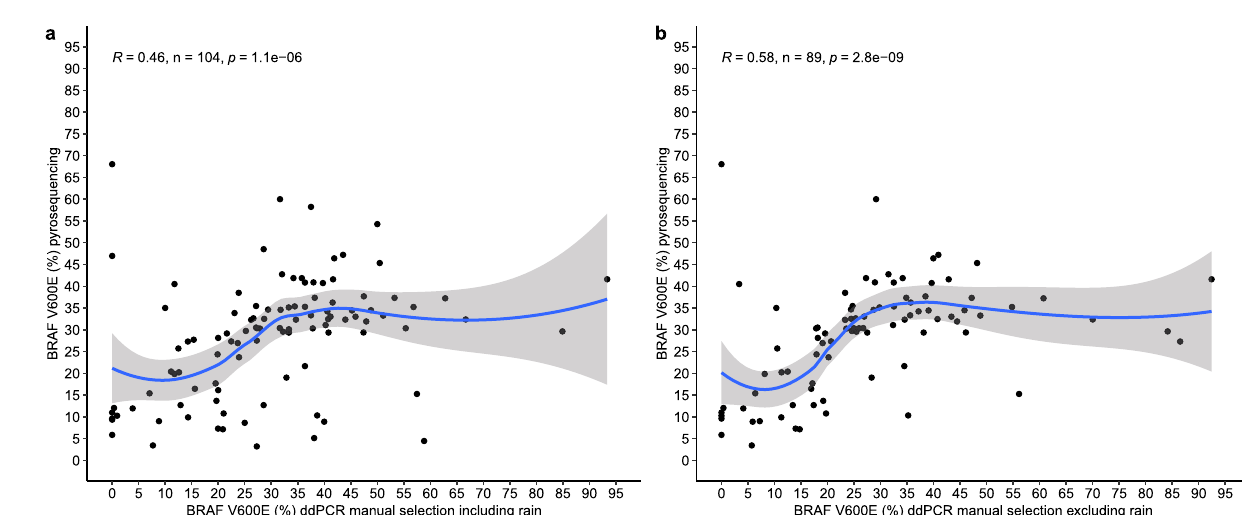
Figure 3. Comparison of the percentage of BRAF V600E mutated allele by ddPCR following manual classification of rain droplets or pyrosequencing. ( a ) Comparison of pyrosequencing with ddPCR following inclusion of rain droplets. This graph shows that some samples have different percentages of BRAF V600E mutated allele if the rain droplets (non-classifiable droplets) were included. ( b ) Comparison of pyrosequencing with ddPCR excluding rain droplets. In this analysis, the confidence interval is squeezed and less extreme values are present, showing that the exclusion of rain droplets soothes lightly the distribution of values. The exclusion of the rain droplets increases the correlation between ddPCR and pyrosequencing. The blue line shows the result of LOESS regression and the gray area shows the 95% confidence interval of the regression. R, N and P are calculated for Spearman correlation